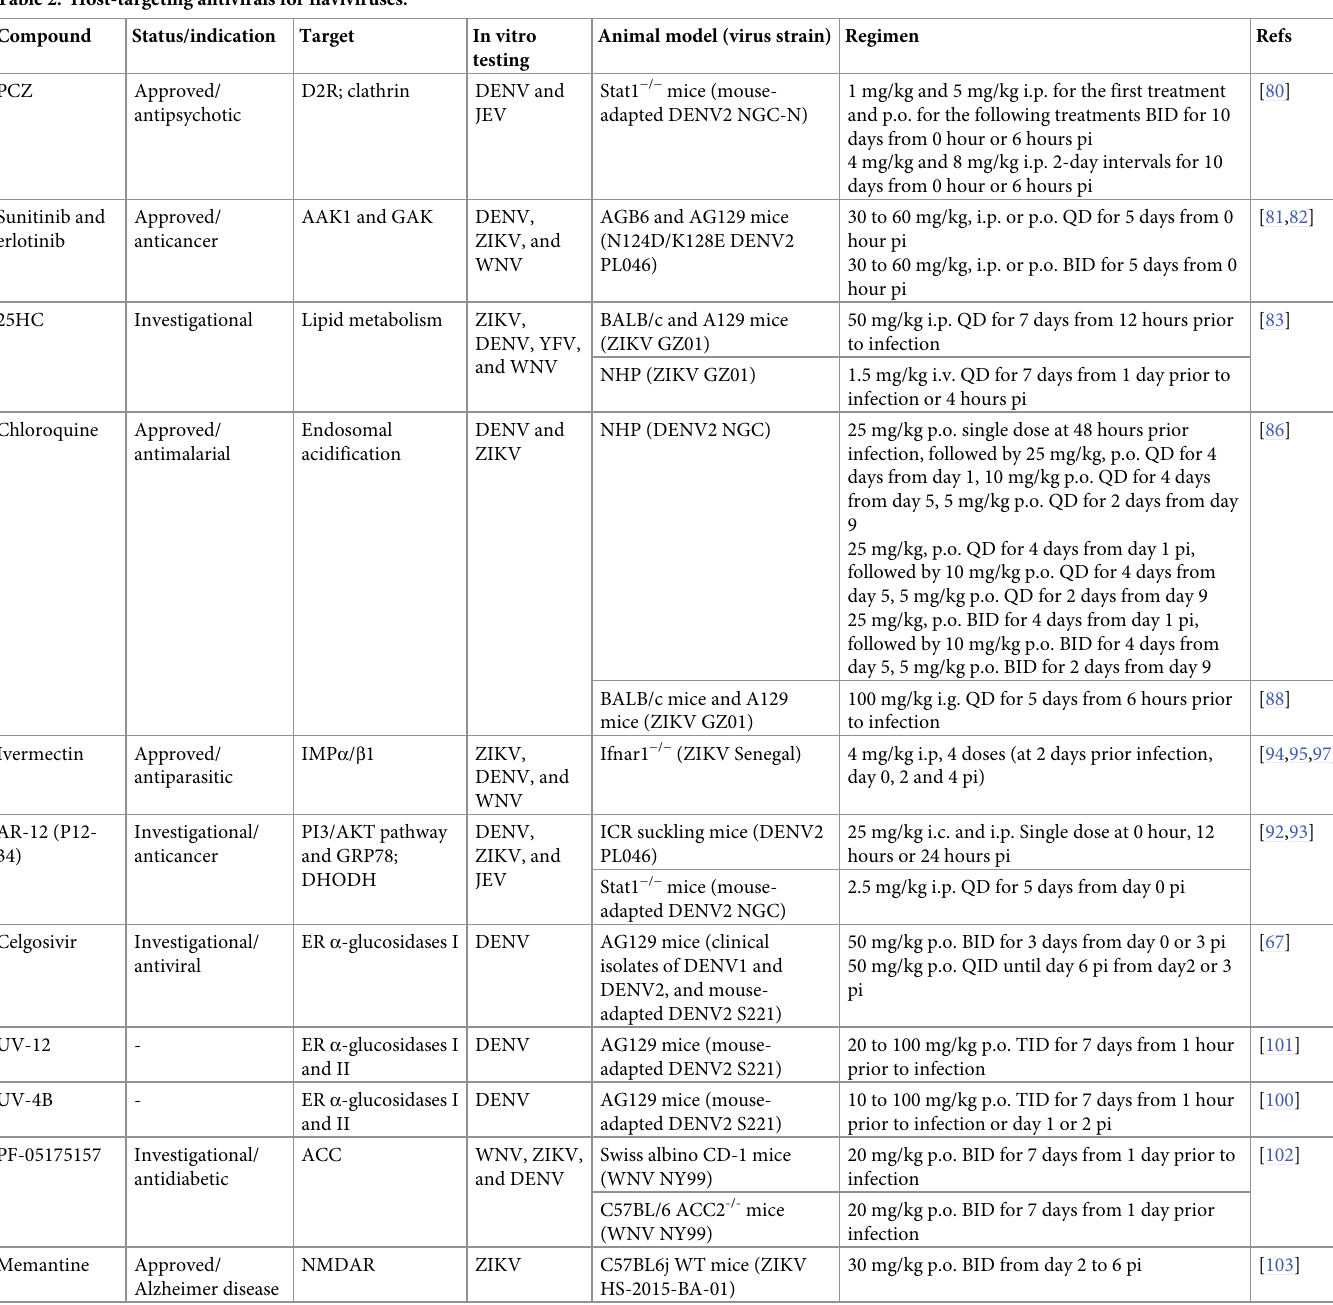
Table 2. Host-targeting antivirals for